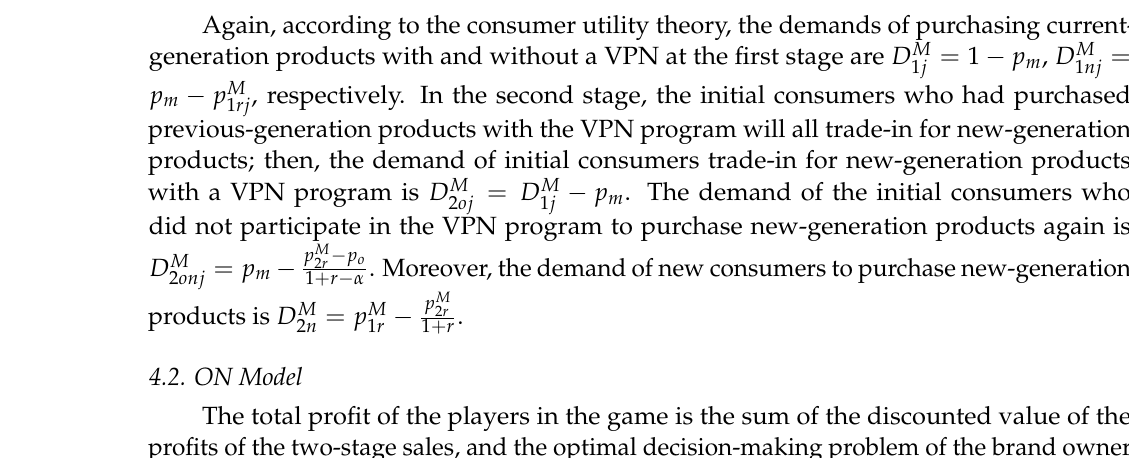
Figure 4. Consumers’ purchasing decision in VPN model.